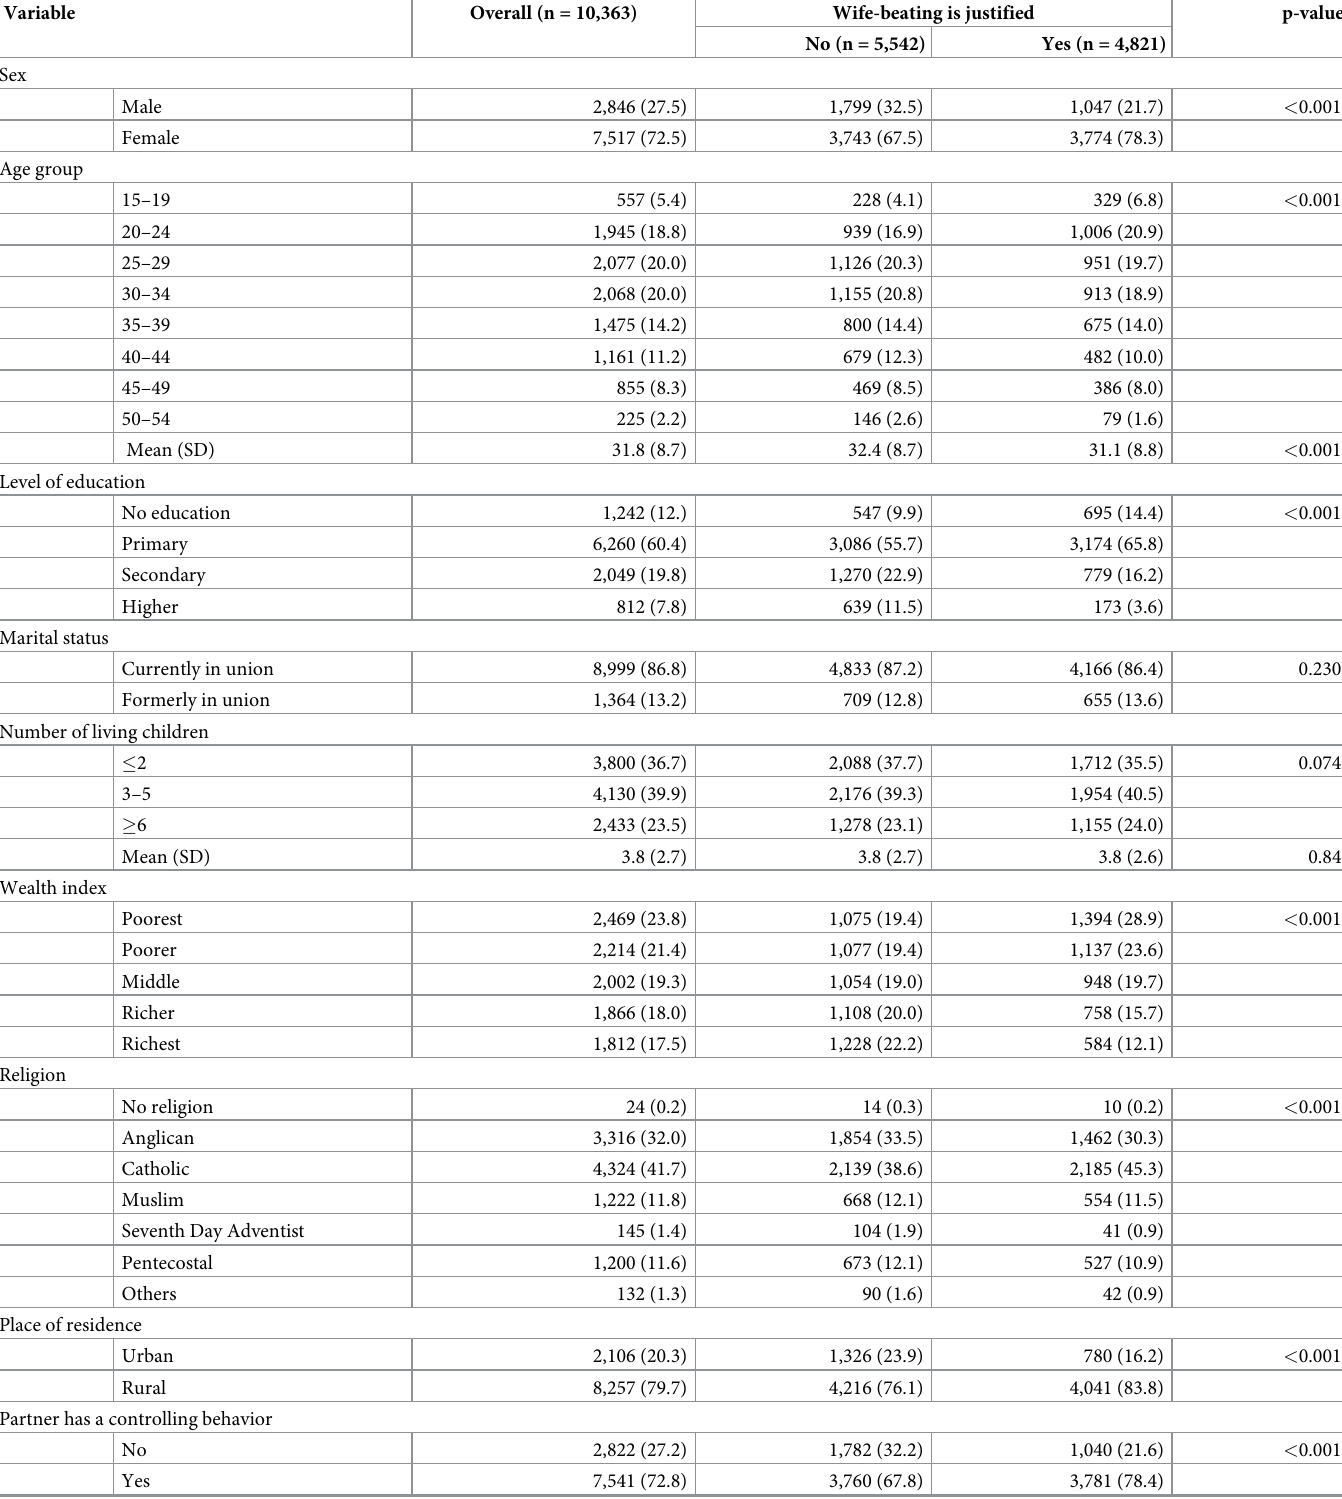
Table 1. Distribution of participant